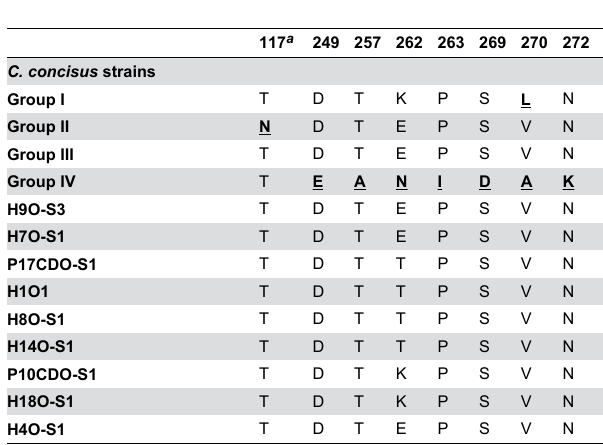
Table 5. Amino acid polymorphisms encoded by Group I, Group II and Group IV C. concisus zot .